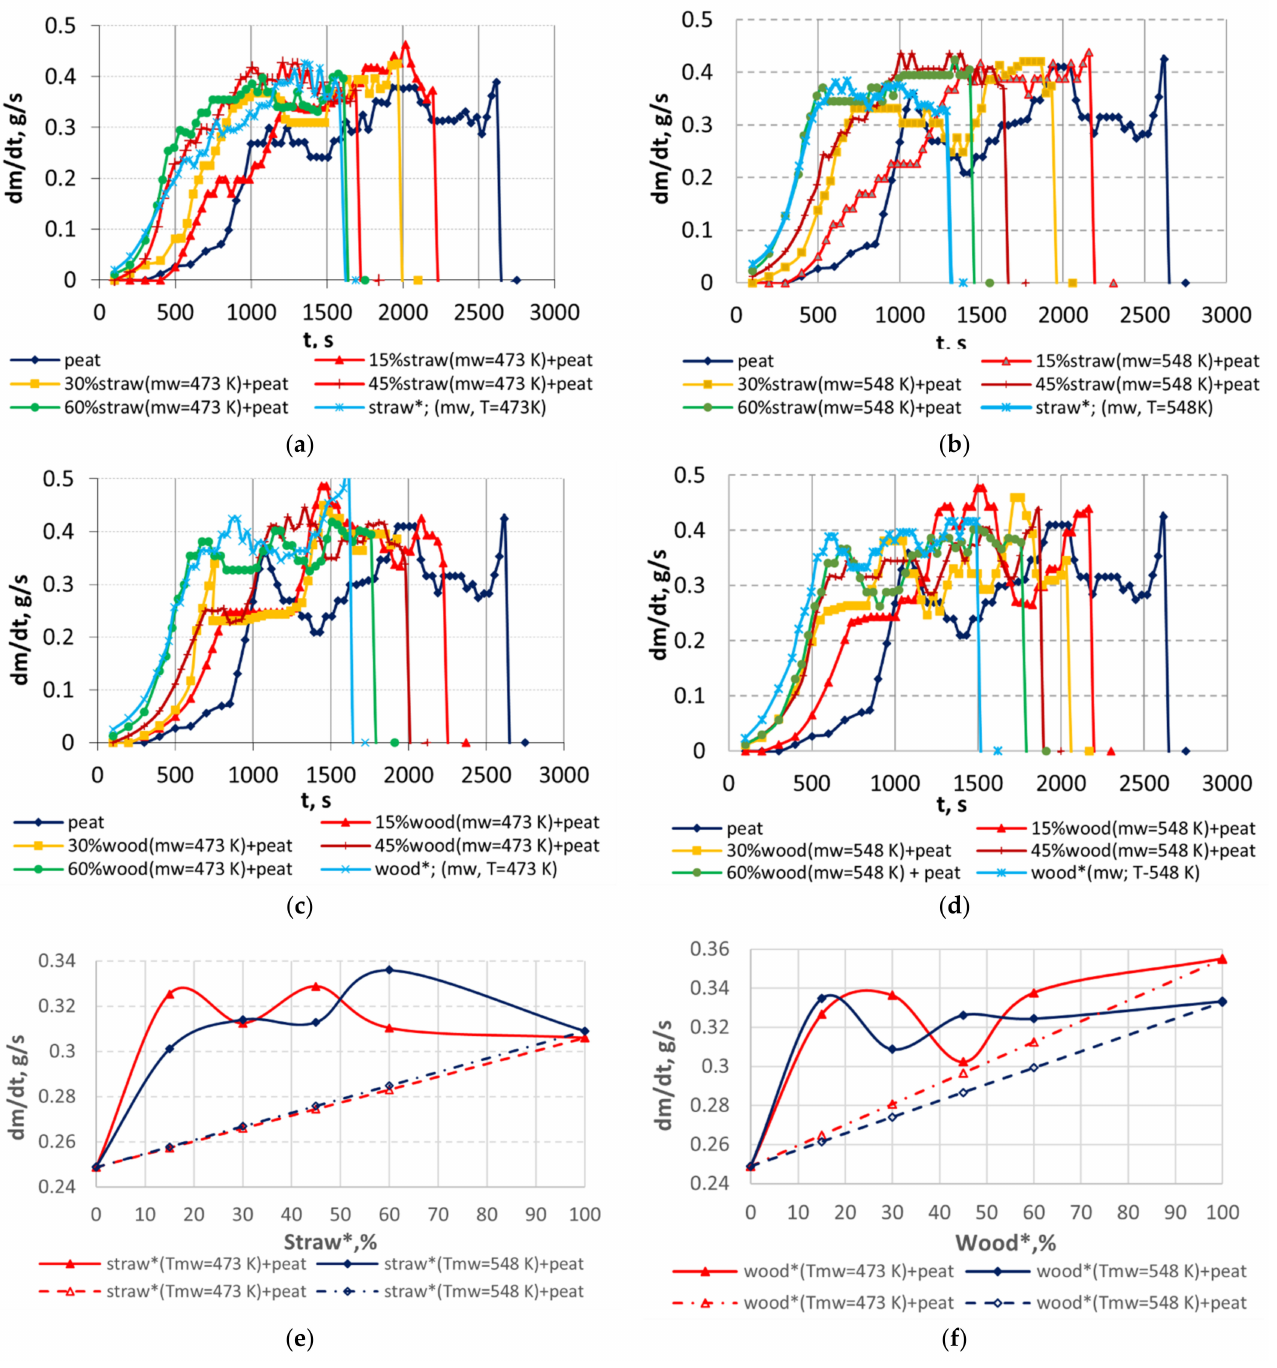
Figure 1. Effect of changes (variations) in pre-treatment temperature and composition of selectively pre-treated wheat straw* ( a , b , e ) and wood* ( c , d , f ) blends with raw peat pellets on the kinetics ( a – d ) and average values ( e , f ) of the weight loss rates of biomass blends, continuous curve experimental data, dashed line linear